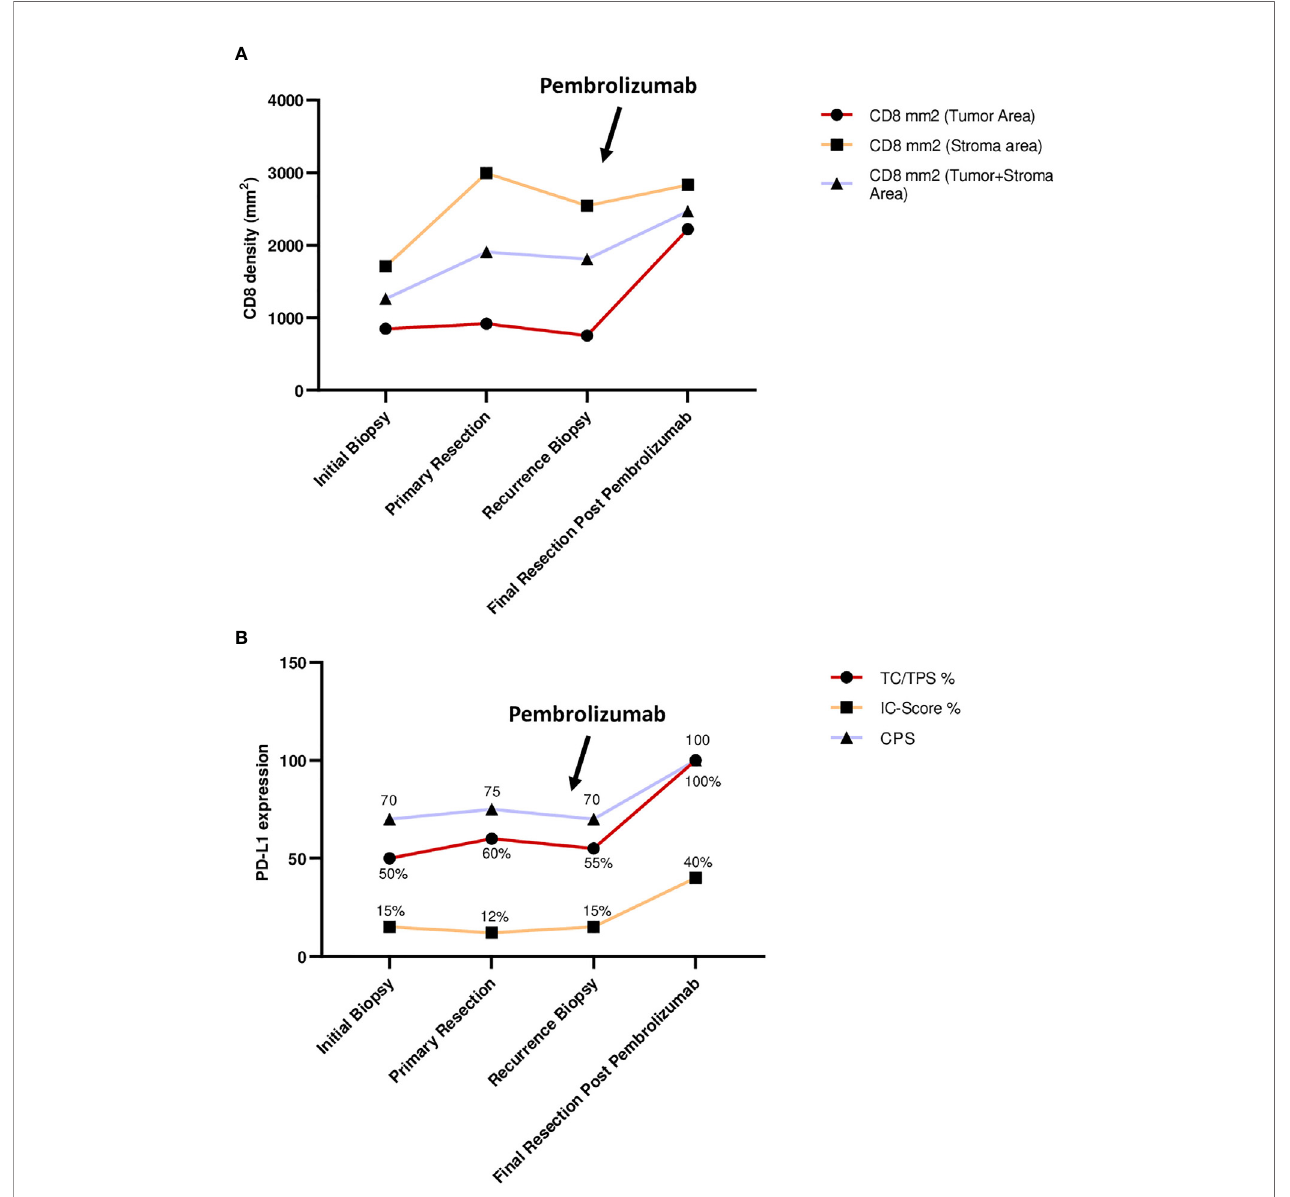
FIGURE 3 | (A) CD8 density (mm2) during treatment. Points of interest/sample collection: initial biopsy, primary resection, recurrence biopsy, fi nal resection after Pembrolizumab. Charts show: CD8+ cells per mm2 in tumor area; CD8+ cells per mm2 in stromal area; CD8 mm2 combined tumor and stromal area. (B) PD-L1 expression during treatment. Points of interest/sample collection: initial biopsy, primary resection, recurrence biopsy, fi nal resection after Pembrolizumab. Charts show: TC, tumor cells; TPS, tumor proportion score in % (stained tumor cells/tumor cells); IC-Score, in fl ammatory cell score (stained in fl ammatory cells/tumor surface); CPS, combined positivity score ((stained tumor cells + stained mononuclear immune cells)/tumor cells), CPS has no